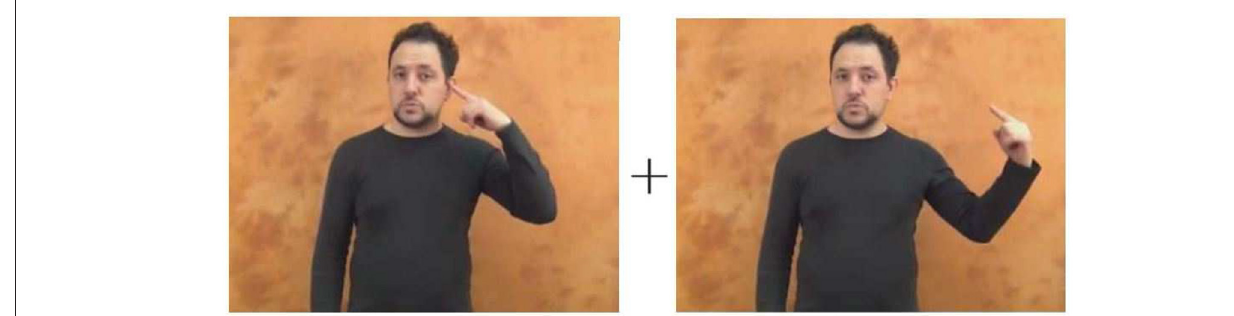
FIGURE 3 | SUONO (sound) – Spread The Sign Dictionary, 2022.